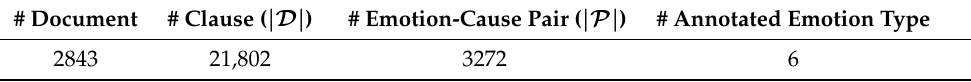
Table 1. Overall information on the English-language corpus dataset. Information on the four main dimensions related to the ECPE task was